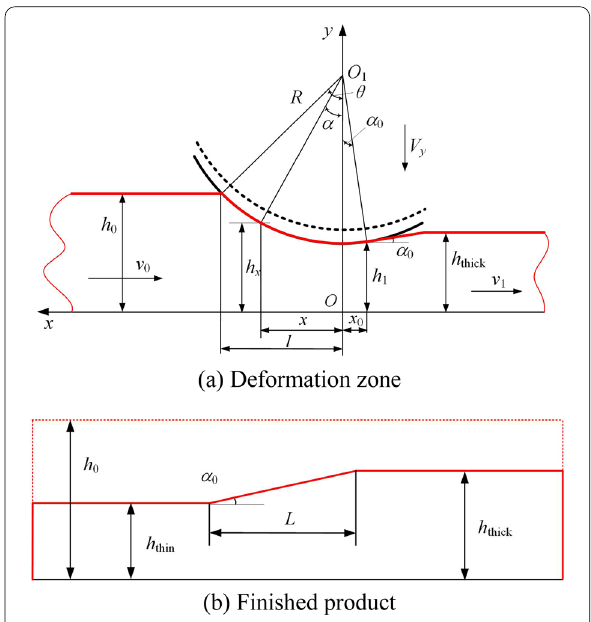
Figure 3 Schematic diagram of the deformation zone and finished product in downward